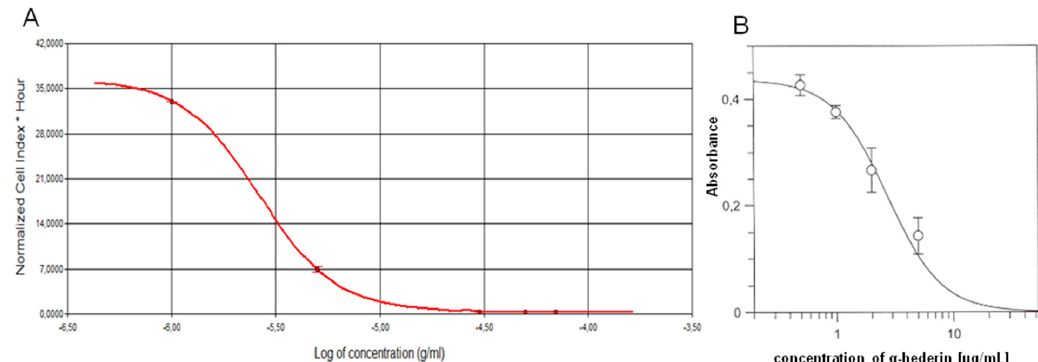
Figure 2. The SKOV-3 cells’ viability declines after the treatment with α -HN. The SKOV-3 cells were incubated with α -HN for 24 h. The curves are labeled with numbers that represent increasing concentrations of α -HN (1–70 μ g/mL, respectively).